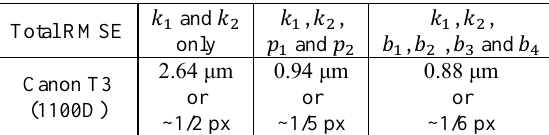
Table 3. RMSE of the residuals for the different calibration adjustments assessing the necessary additional parameters